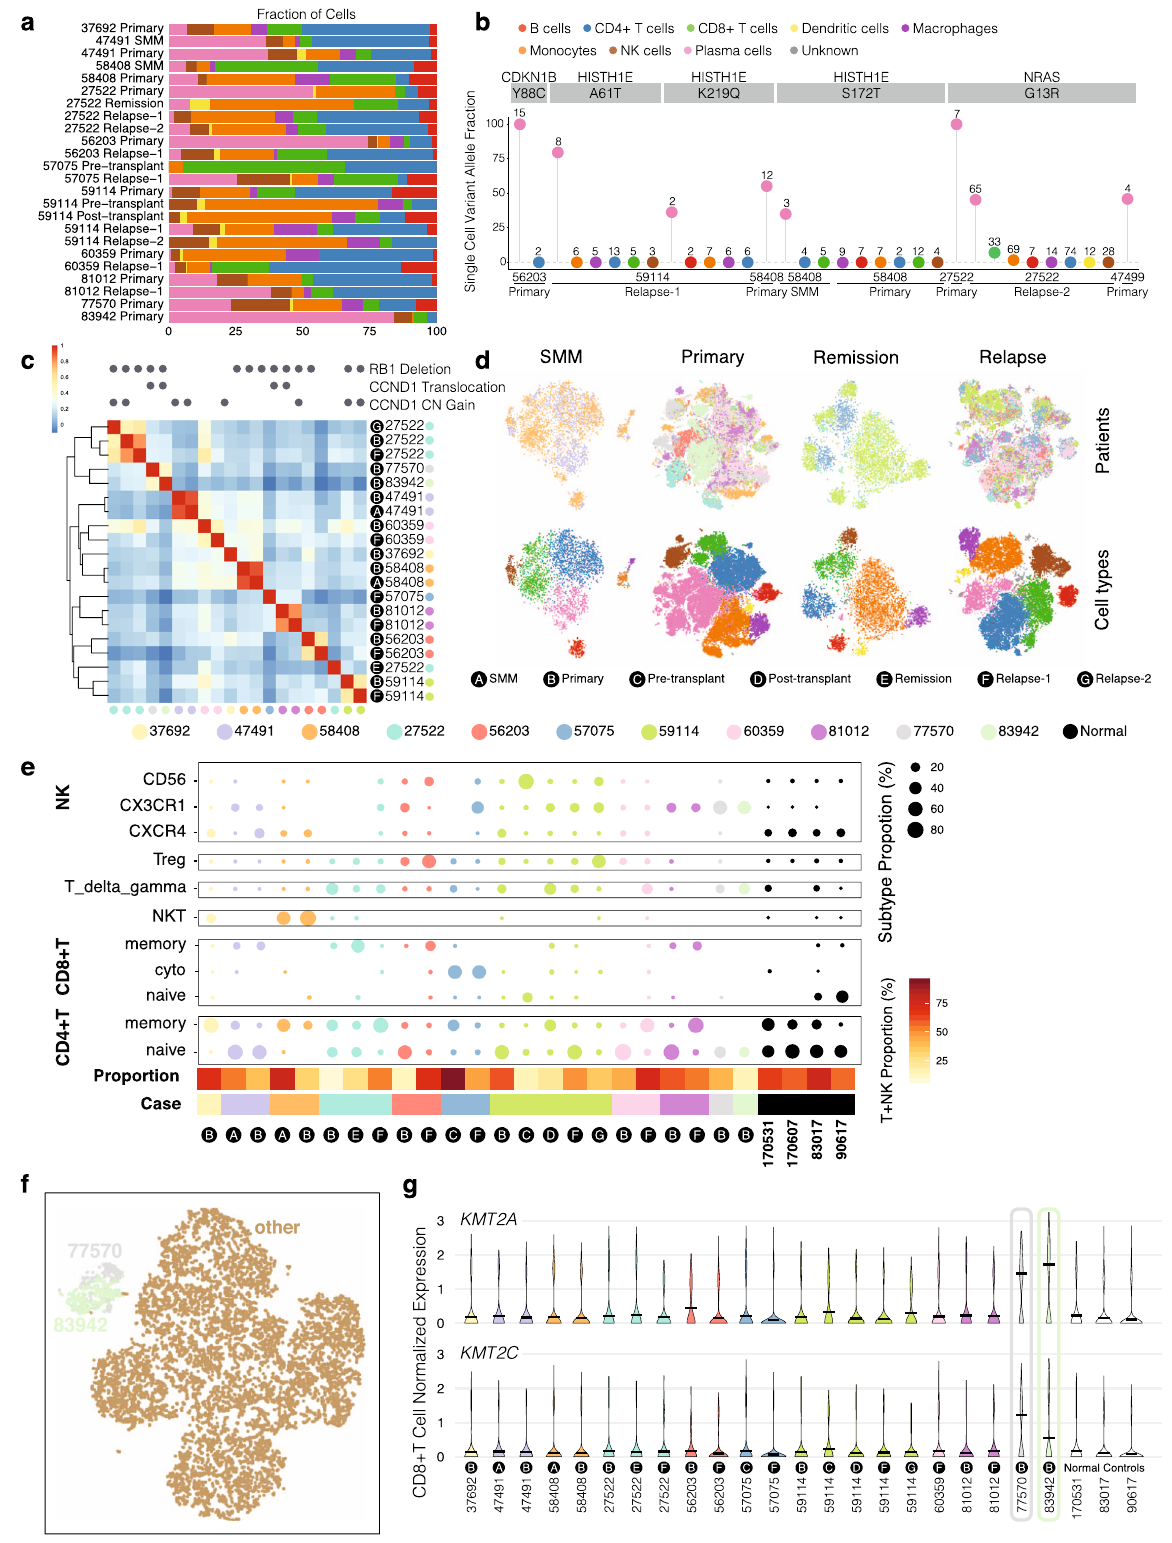
samples in other patients, which could re fl ect treatment as a factor in altering expression pro fi les of malignant plasma cells. Expression pro fi les also partially clustered by genetic alterations; Patients 77570 and 83942 both harbor CCND1 translocation, and their plasma cell expression pro fi les are more similar than others (Fig. 2c, Supplementary Data 3 and